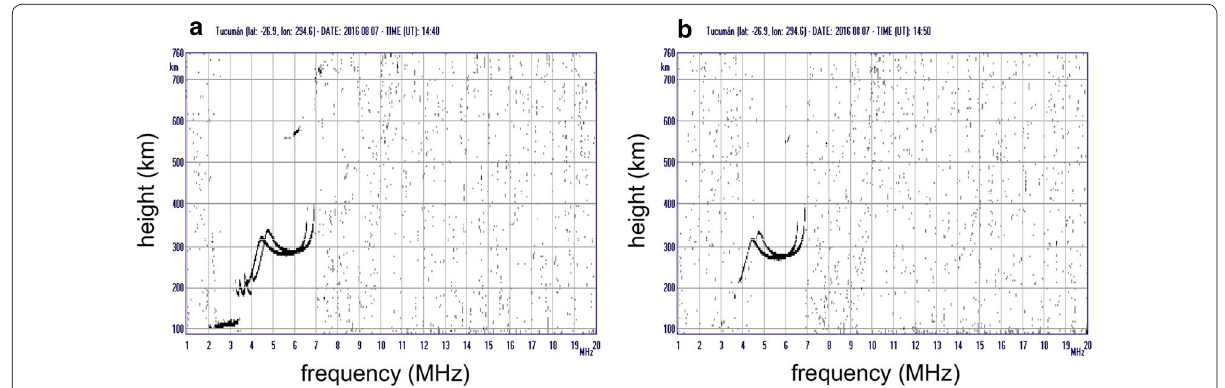
Fig. 12 Ionograms recorded in Tucumán on 7 August 2016 at a 14:40 UT and b 14:50